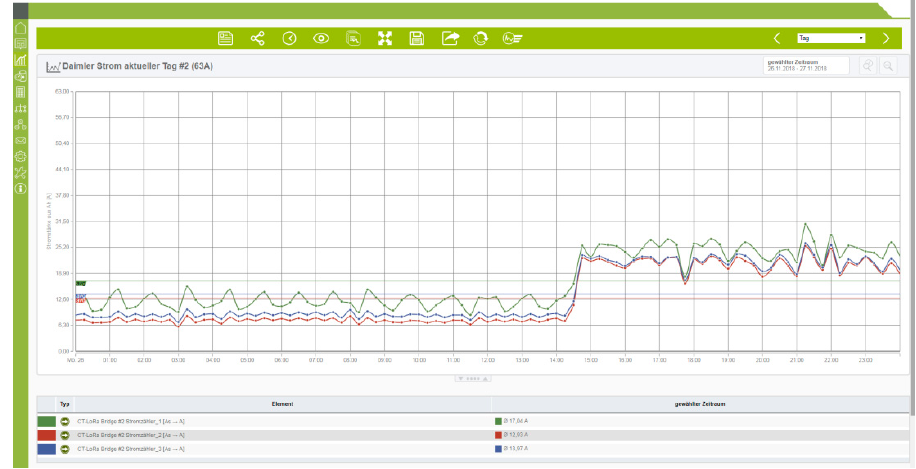
Figure 8. EMS chart of the measured current transformers (CT).